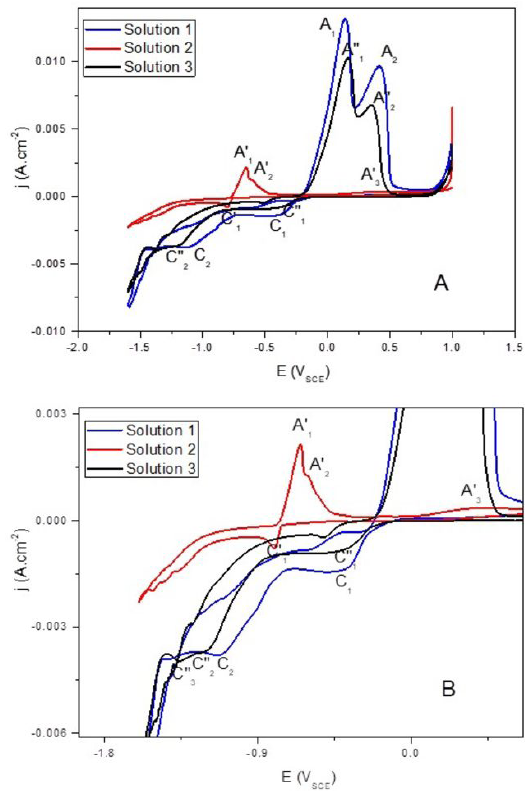
Figure 1. (A) Cyclic voltammetry for graphite in the solutions of Table 1 ; (B) Magnification of the cathodic